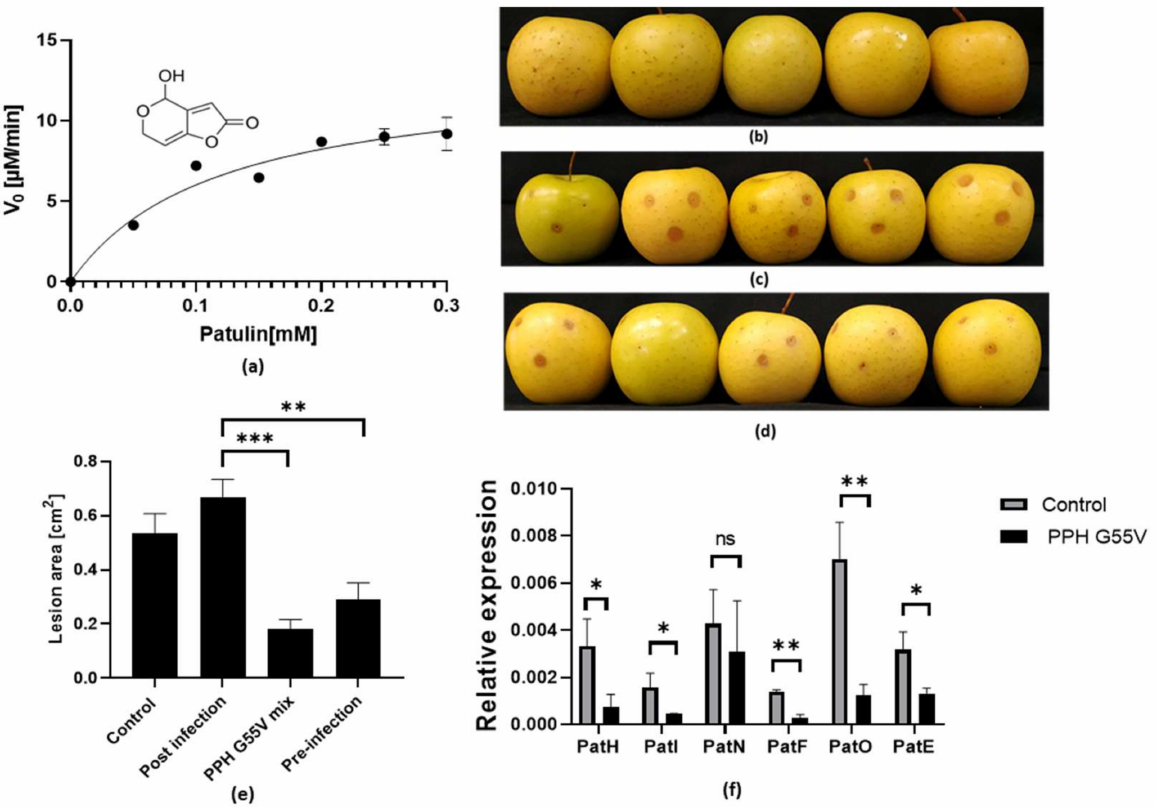
Figure 1. Bacterial lactonase degrades patulin in vitro, inhibits apples’ colonization, and inhibits gene expression of P. expansum patulin biosynthetic cluster in colonized apples. ( a ) Michaelis–Menten kinetics analysis tested with 0.3 µ M of bacterial lactonase (PPH-G55V) and Patulin at pH 7.5, 25 ◦ C. ( b – d ) The addition of 2 µ M PPH-G55V to P. expansum spores resulted in reduced colonized area. ( b ) Non-infected apples, ( c ) apples infected with P. expansum cultures, ( d ) apples infected with P. expansum after cultures incubation with 2 µ M PPH-G55V. Pictures were taken three days post-infection. ( e ) Lesion size in cm2 of treated apples after 3 days inoculation with P. expansum . Mean values are presented (*** p < 0.0005, ** p < 0.0047 according to one-way ANOVA followed by Tukey–Kramer). ( f ) The relative expression levels of